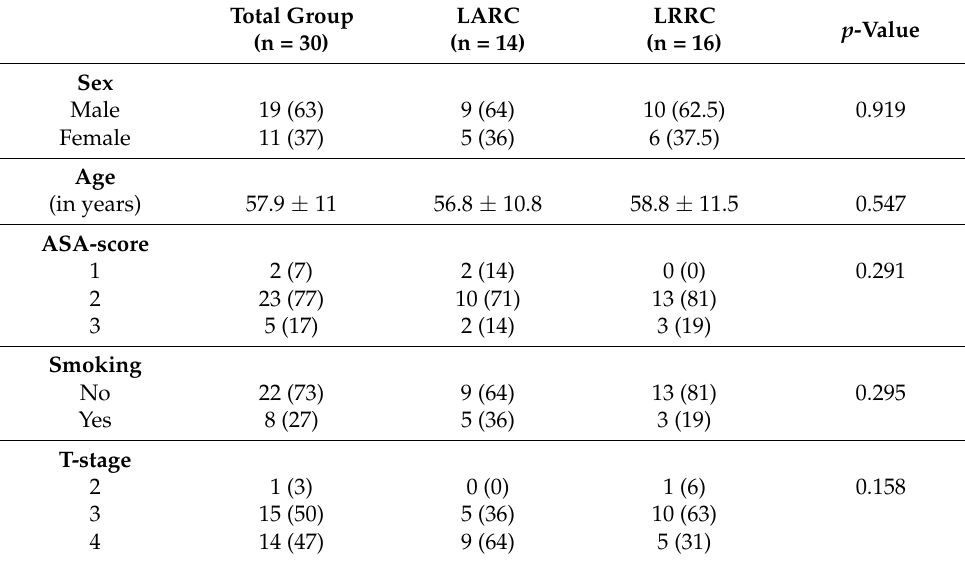
Table 1. Baseline characteristics of the study